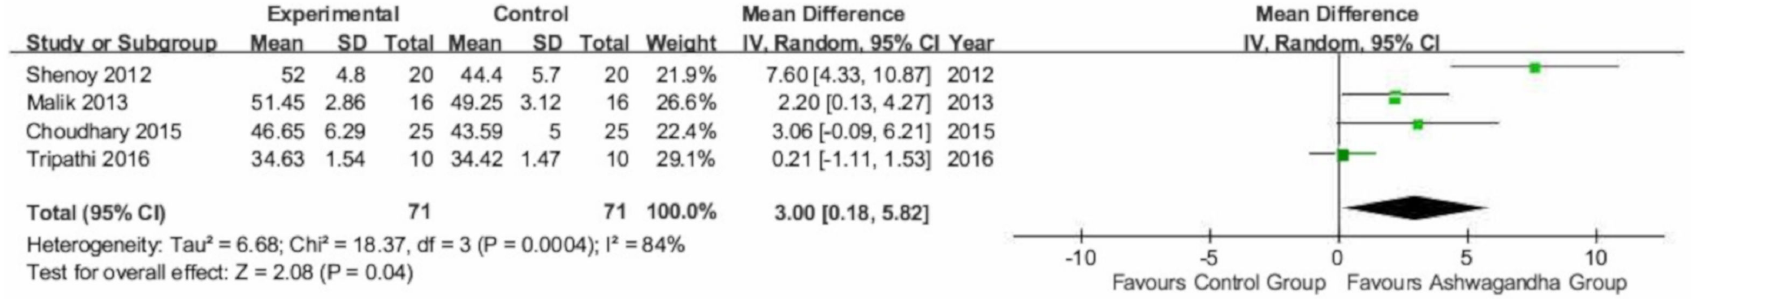
Figure 3. Meta-analysis results of the e ff ects of Ashwagandha supplementation on VO 2max